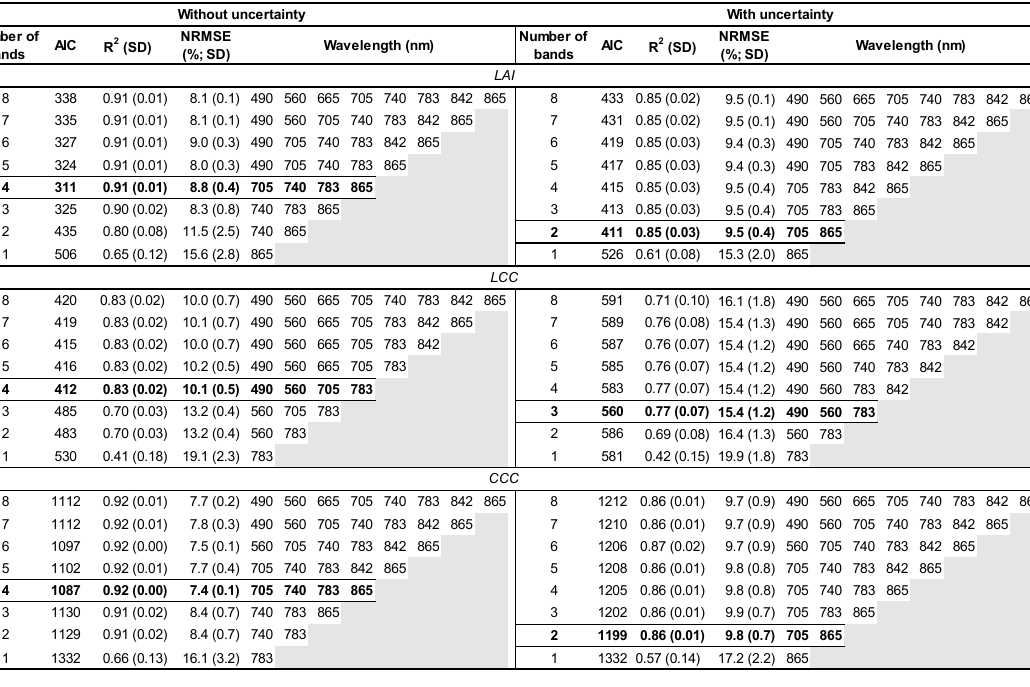
Figure 3. Sentinel-2 band analysis using Gaussian processes regression (GPR) modelling trained using multi-date wheat observation, both without (left) and with (right) accounting for uncertainty in observations, for deriving Leaf Area Index (LAI), leaf chlorophyll content (LCC) and canopy chlorophyll content (CCC). Statics include the mean and standard deviations of the coefficient of determination (R 2 ) and normalised root-mean-square-error (NRMSE) from a three-fold cross-validation of the corresponding GPR models. The best performing GPR model, selected based on the lowest Akaike information criterion (AIC) value, is shown in boldface. Table 3. Summary of regression analysis statistics, including the coe ffi cient of determination (R 2 ) and normalised root-mean-square-error (NRMSE), from comparing single-band and multivariate linear regression and Gaussian processes regression (GPR) modelling for retrieving ground measurements of LAI and